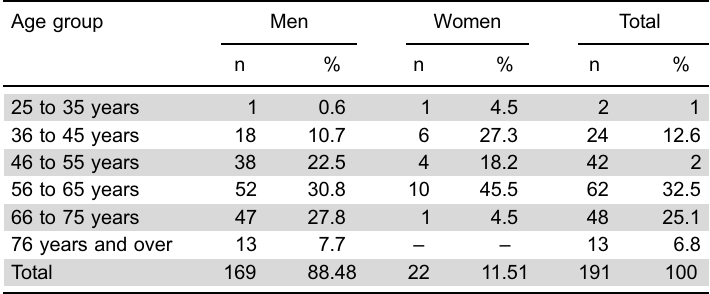
Table 1. Age groups of doctors with a lawsuit according to